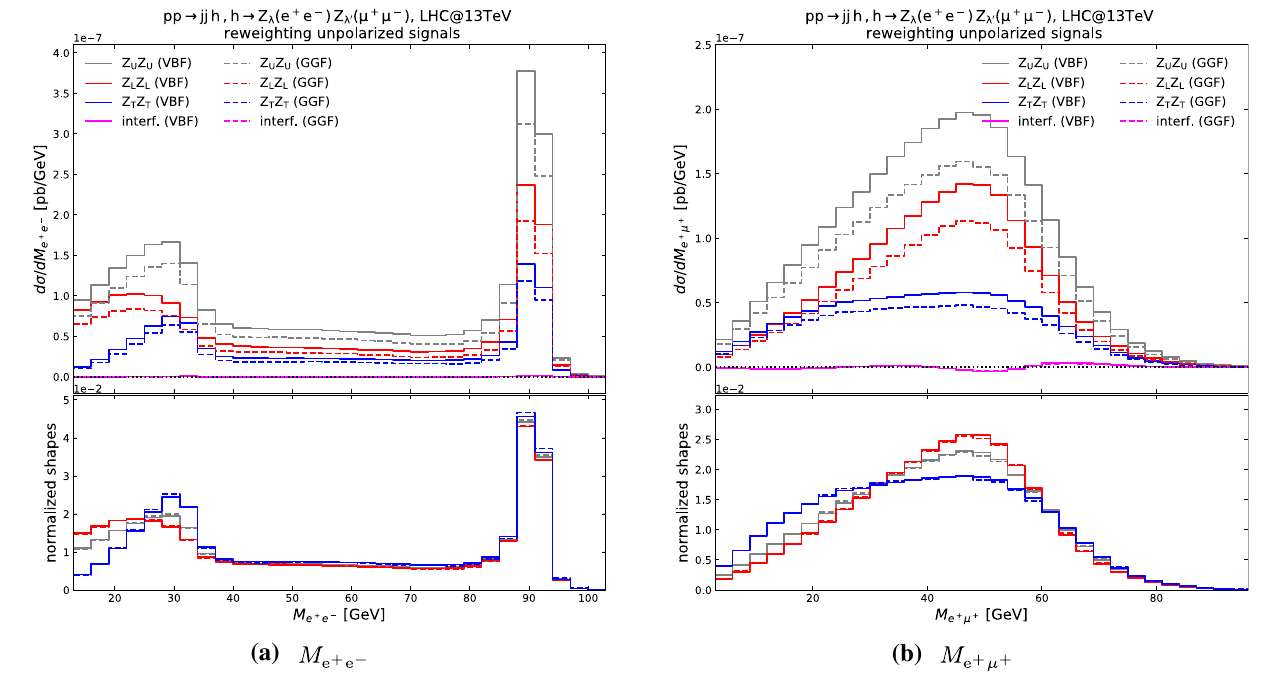
Fig. 5 Distributions for Higgs production in GGF (dashed curves) and VBF (solid curves) at the LHC@13TeV: invariant mass of the positron- electron pair ( a ) and of the positron-antimuon pair ( b ). Same structure as Fig. 3 ) functional dependence, since the interference cos ( 2 Δφ ∗ e + μ + between left and right modes is included in the